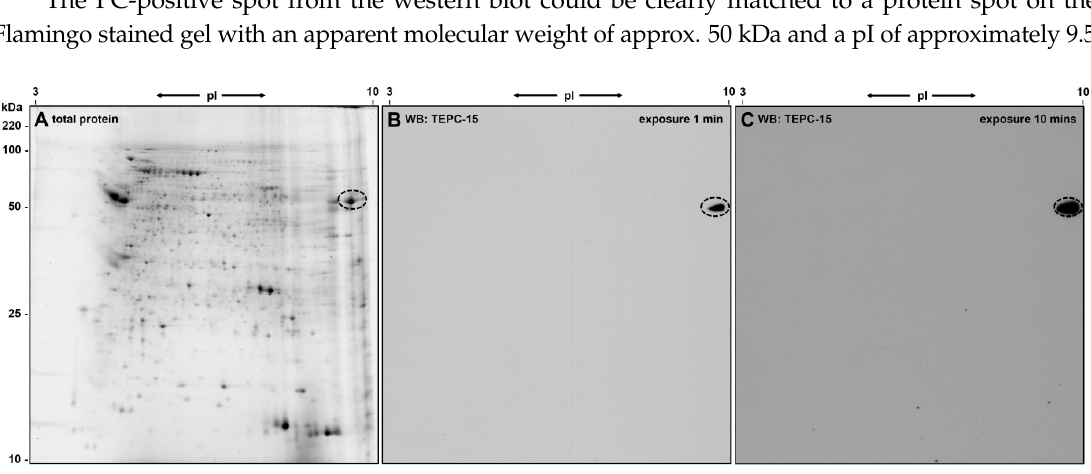
Figure 2. 2D-Gel electrophoretic separation of L. infantum proteins. ( A ) Gel stained with Flamingo for total protein visualization and ( B , C ) ECLs of a Western blot probed with the PC-specific antibody TEPC15. One spot is detected as being PC-modified, even if the film is overexposed: image ( C ) is exposed for 10 min, although the spot is already visible after 1 min ( B ). The corresponding spot in ( A ) is labelled with a circle.